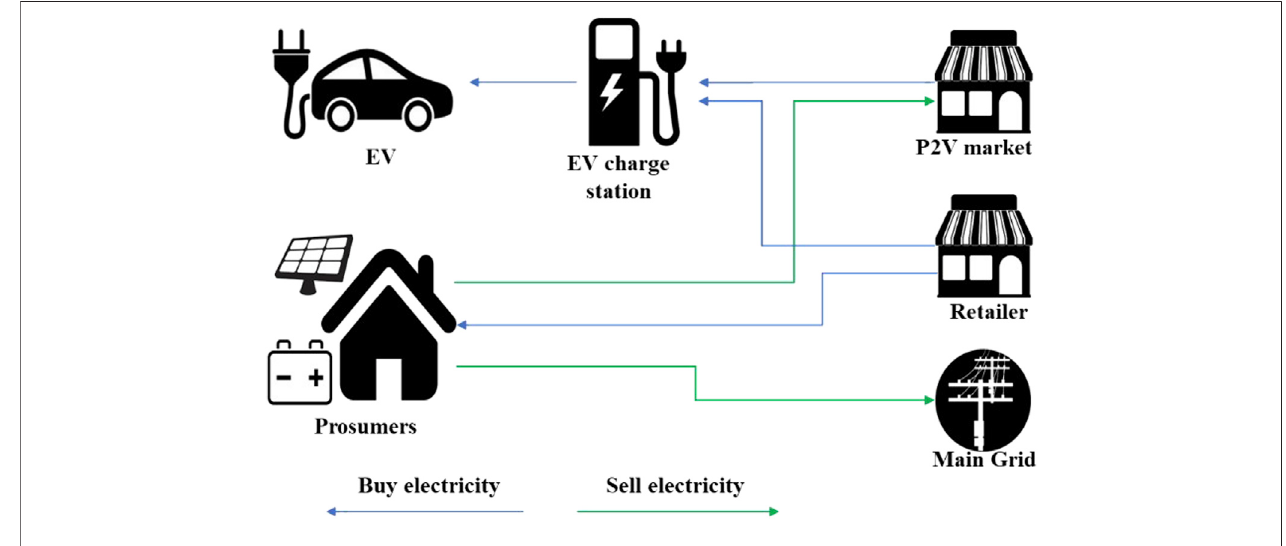
FIGURE 1 | Proposed model